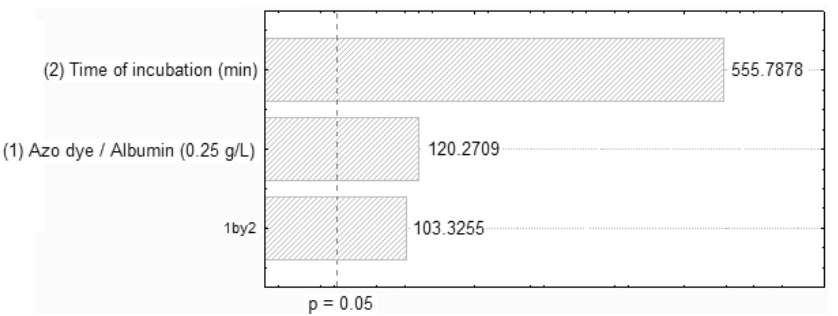
Figure 2. Pareto chart of standardized effects of removing Orange II related to azo dye/albumin (0.25 g/L) concentrations and time of incubation.